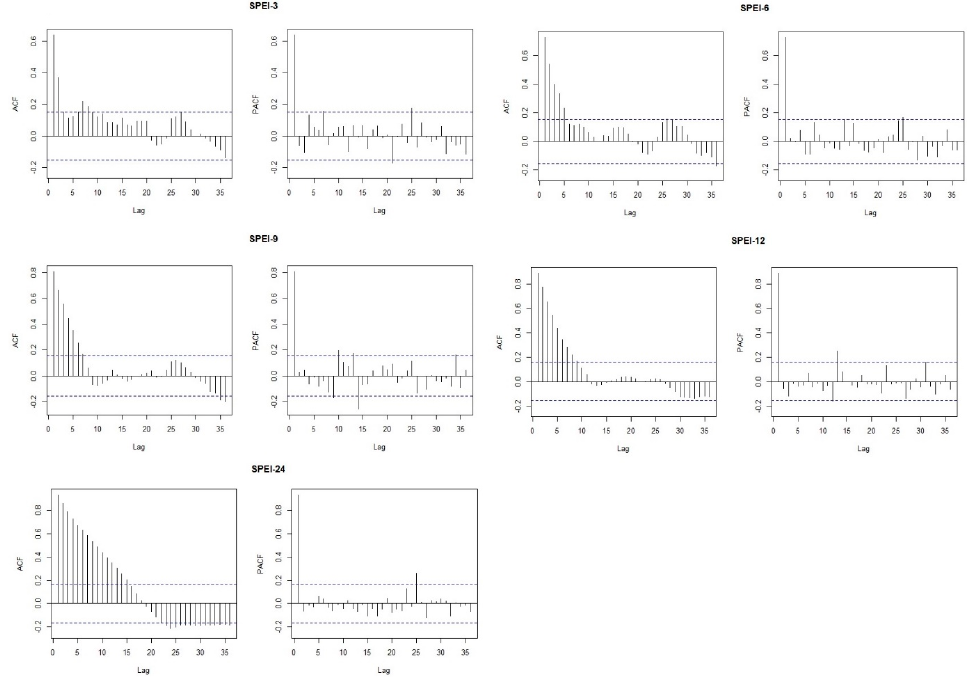
Figure 7. ACF and PACF of SPEI- 3, 6, 9, 12 and 24 from this we can identified the data is stationary. From the Figure 5 for PACF and ACF it is clearly shown that the selected data is stationary.